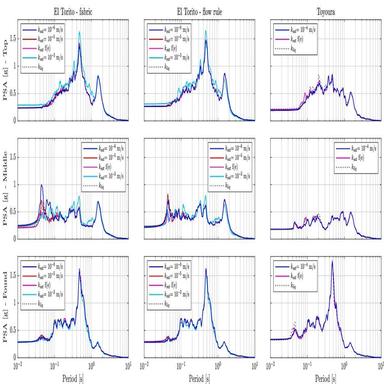
Acceleration response spectra results at the top, middle and the foundation of site response models for both sands and calibrations.